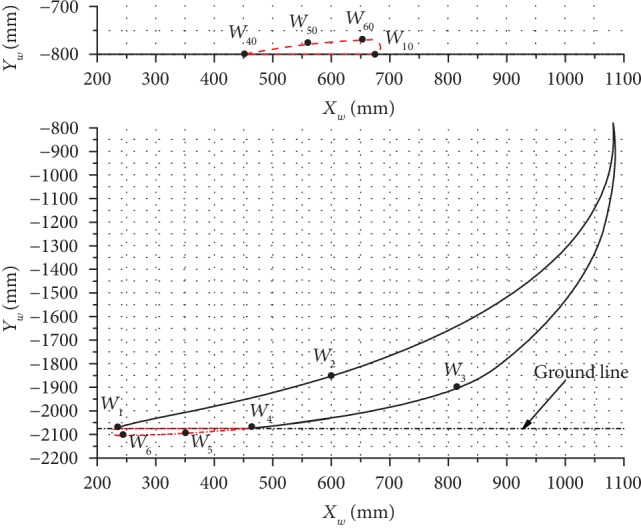
The trajectories of the leg end-point (bottom) and the body (top) at α1 = 18.5°.